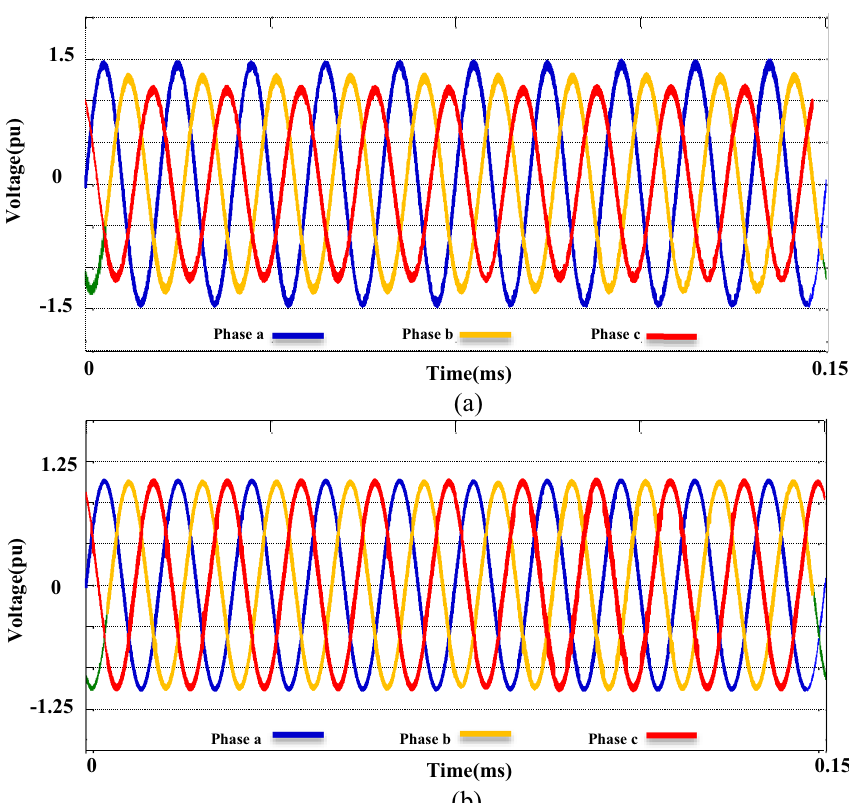
Figure 15. Three phase unbalanced output voltage; ( a ) without the M-UPQC module, ( b ) with the M-UPQC